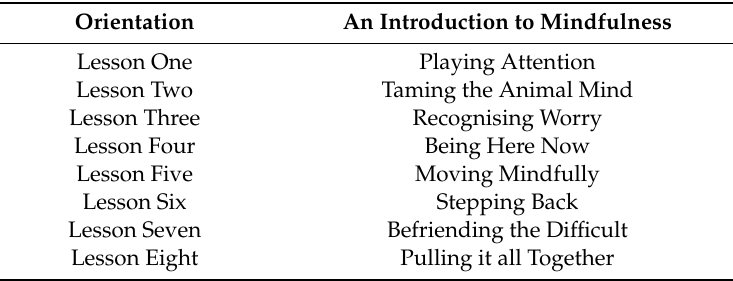
Table 1. Themes of each .b